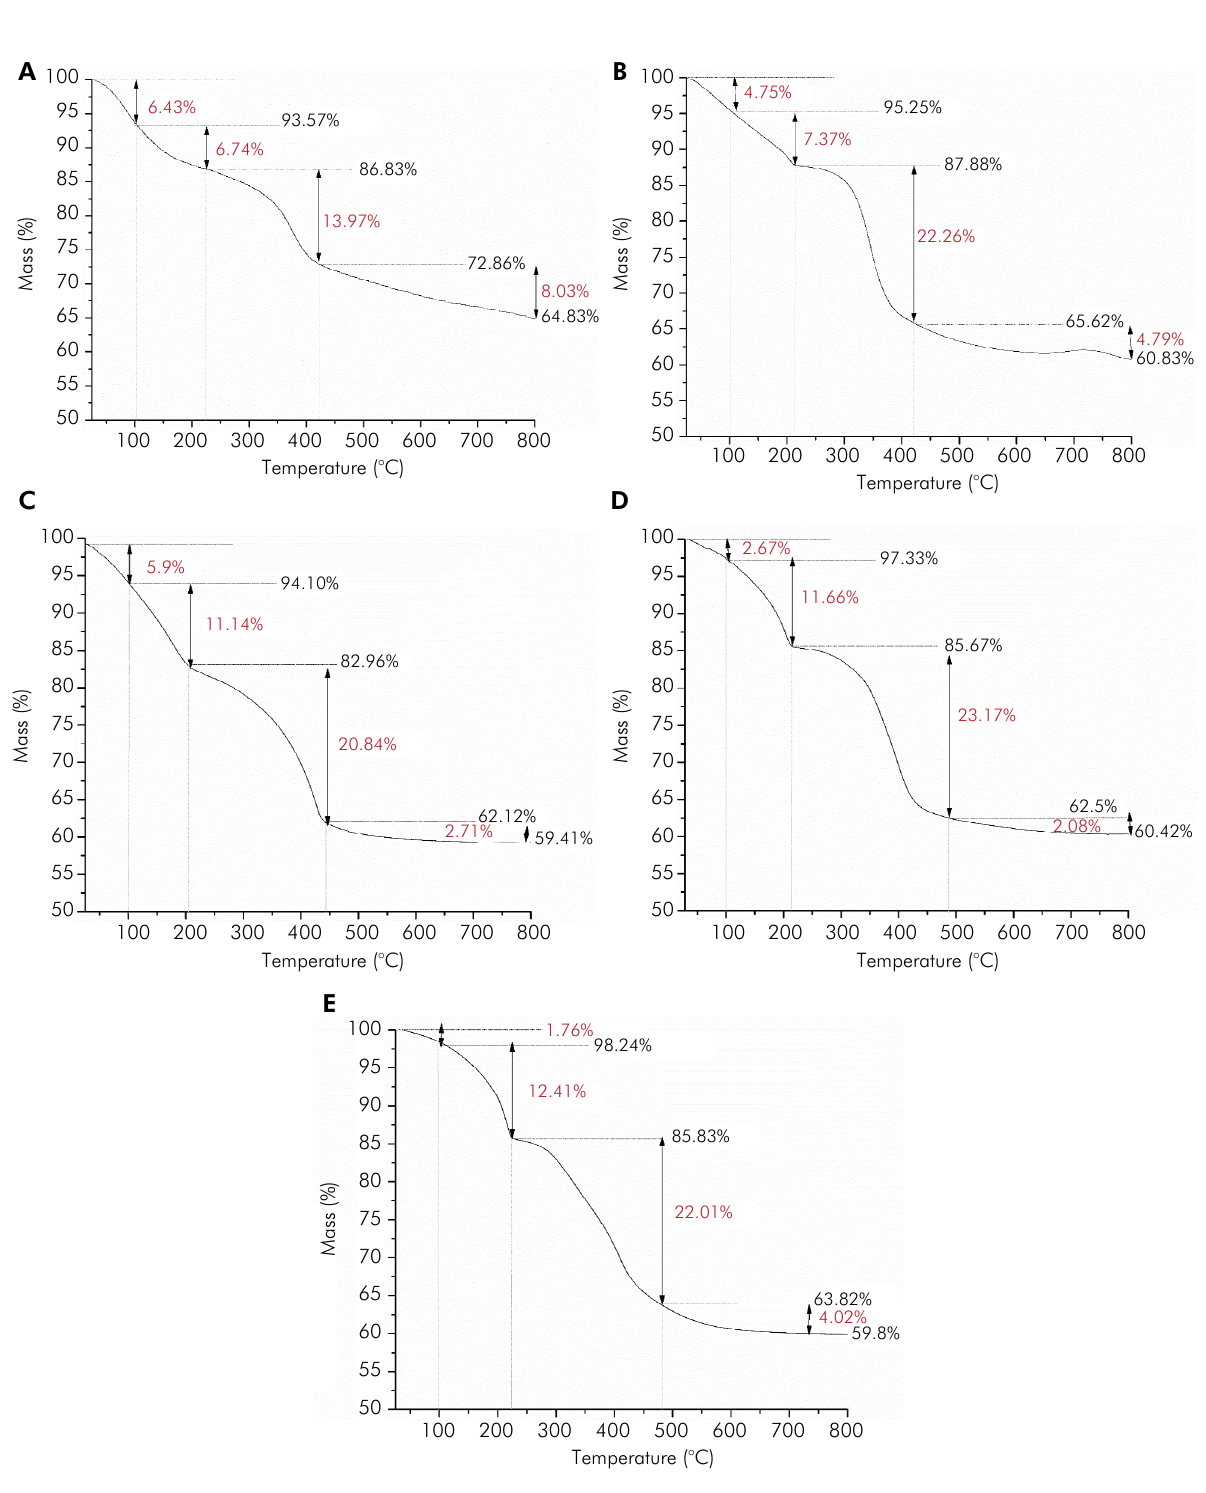
Figure 3. Thermal degradation curves of precursors C-LDH (A) and N-LDH (B). (C), (D), and (E) illustrate the TGA of F-LDH synthesis at 25°C for 2 h. Fluoride product (F-LDH/1) synthesis from C-LDH precursor (C). Fluoride product (F-LDH/5) synthesis from N-LDH colloidal suspension (D). Fluorinated product (F-LDH/9) synthesis from N-LDH powder (E). Note, an initial mass loss occurs between 25 and 200°C (volatilization of adsorbed water and interlamellar water, respectively). For 200–430°C and 450–800°C, the third and fourth decomposition stages show structural dehydroxylation and loss of CO and consequently, the lamellar structure, 2 respectively. For fluoride products, higher decomposition temperatures are required for material degradation ((C), (D), and